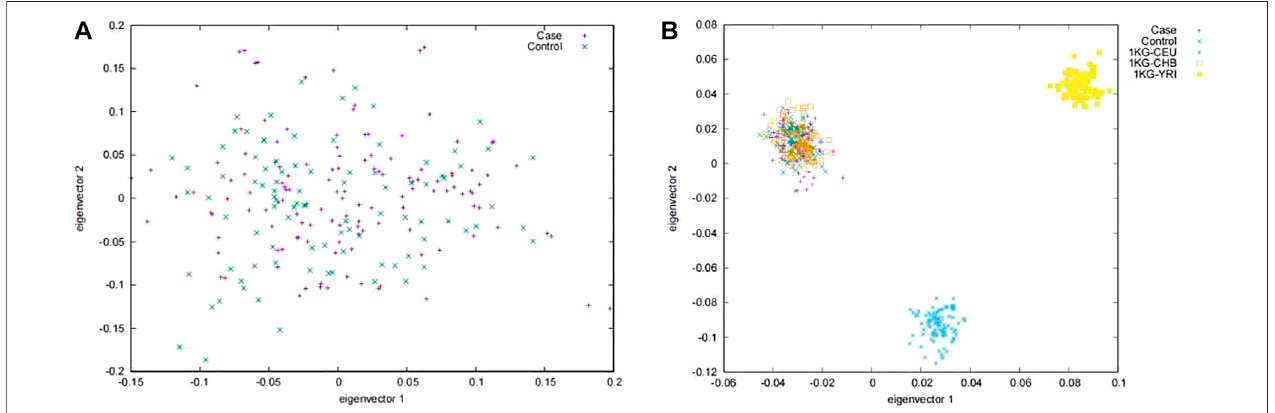
FIGURE 1 | Principal component analysis in (A) the Chinese Tibetan population and (B) the reference sample in the international 1,000 genomes project. Case, Patientswithgallstones;Control,Healthycontrolpopulation;CEU,UtahResidents(CEPH)withNorthernandWesternEuropeanAncestry;CHB,HanChineseinBeijing, China; YRI, Yoruba in Ibadan,